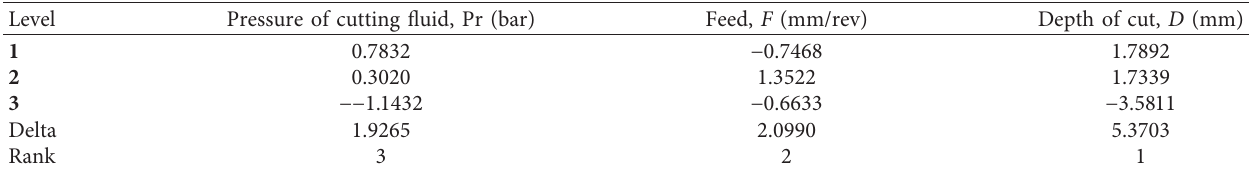
Table 4: Tool wear response ratios of signal to